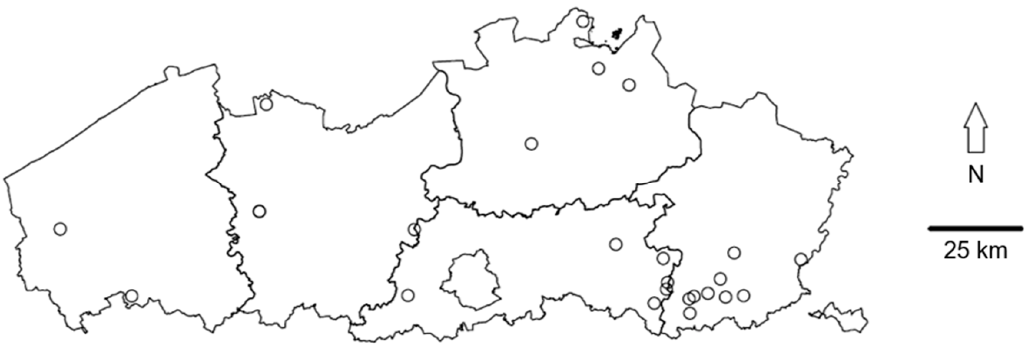
Figure 1. Map of Flanders in Belgium that shows the location of the 24 sweet cherry growers (circles) that took part in the study.